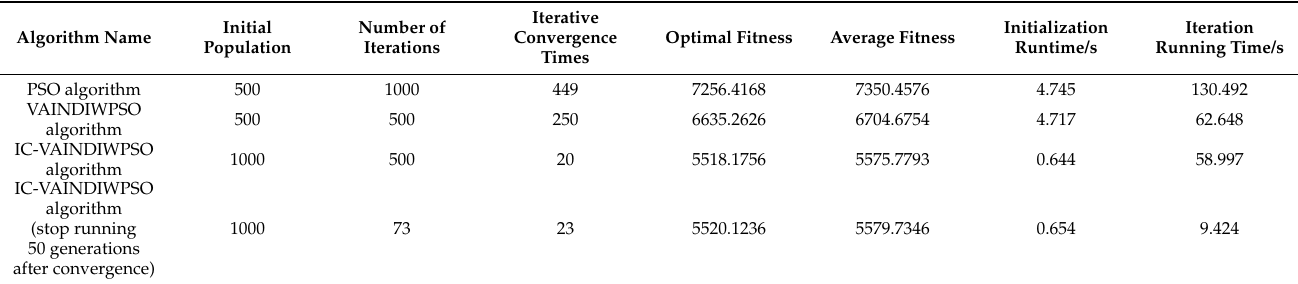
Figure 7. Convergence graph of fitness function of three algorithms.